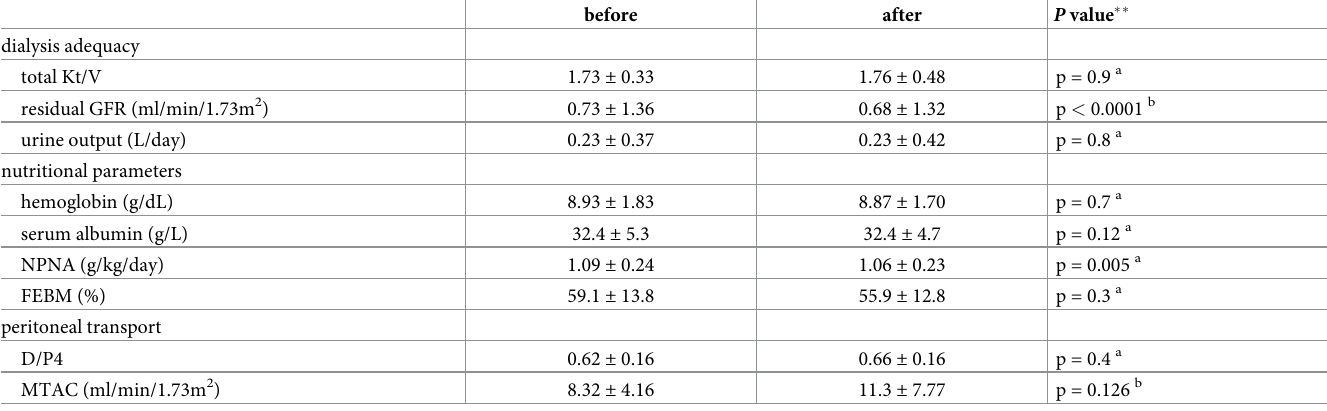
Table 3. Changes in peritoneal transport, nutritional status, and dialysis adequacy before and after the episode of Pseudomonas peritonitis (cid:3) .